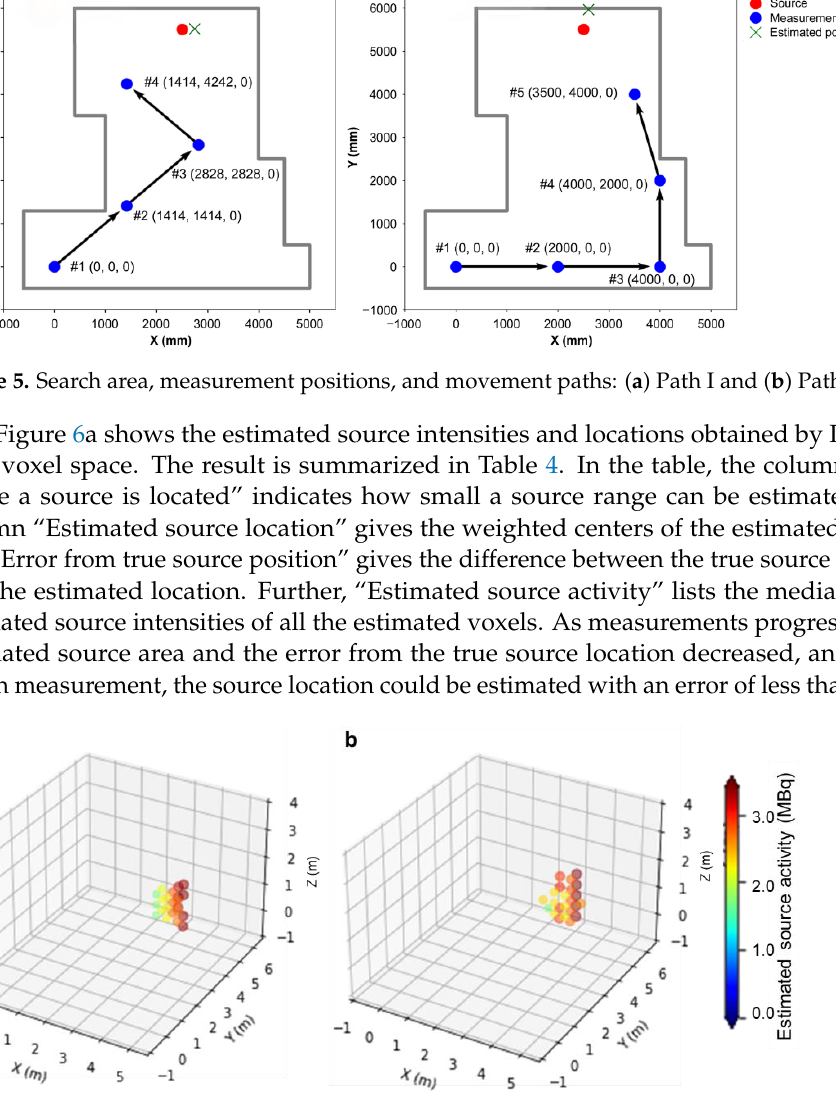
Figure 6. Estimated source intensities and locations in a three-dimensional (3D) voxel space obtained by ( a ) Path I and ( b ) Path II. Table 4. Summary of the estimated source intensities and locations obtained by Path I in the integrated simulation model.